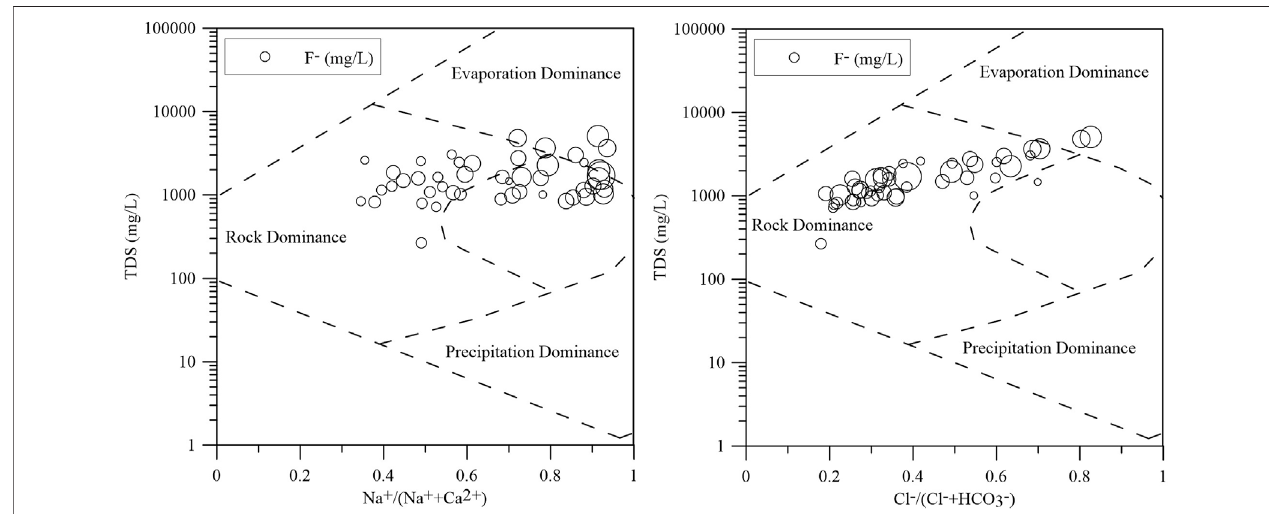
FIGURE 5 | Gibbs diagram of groundwater